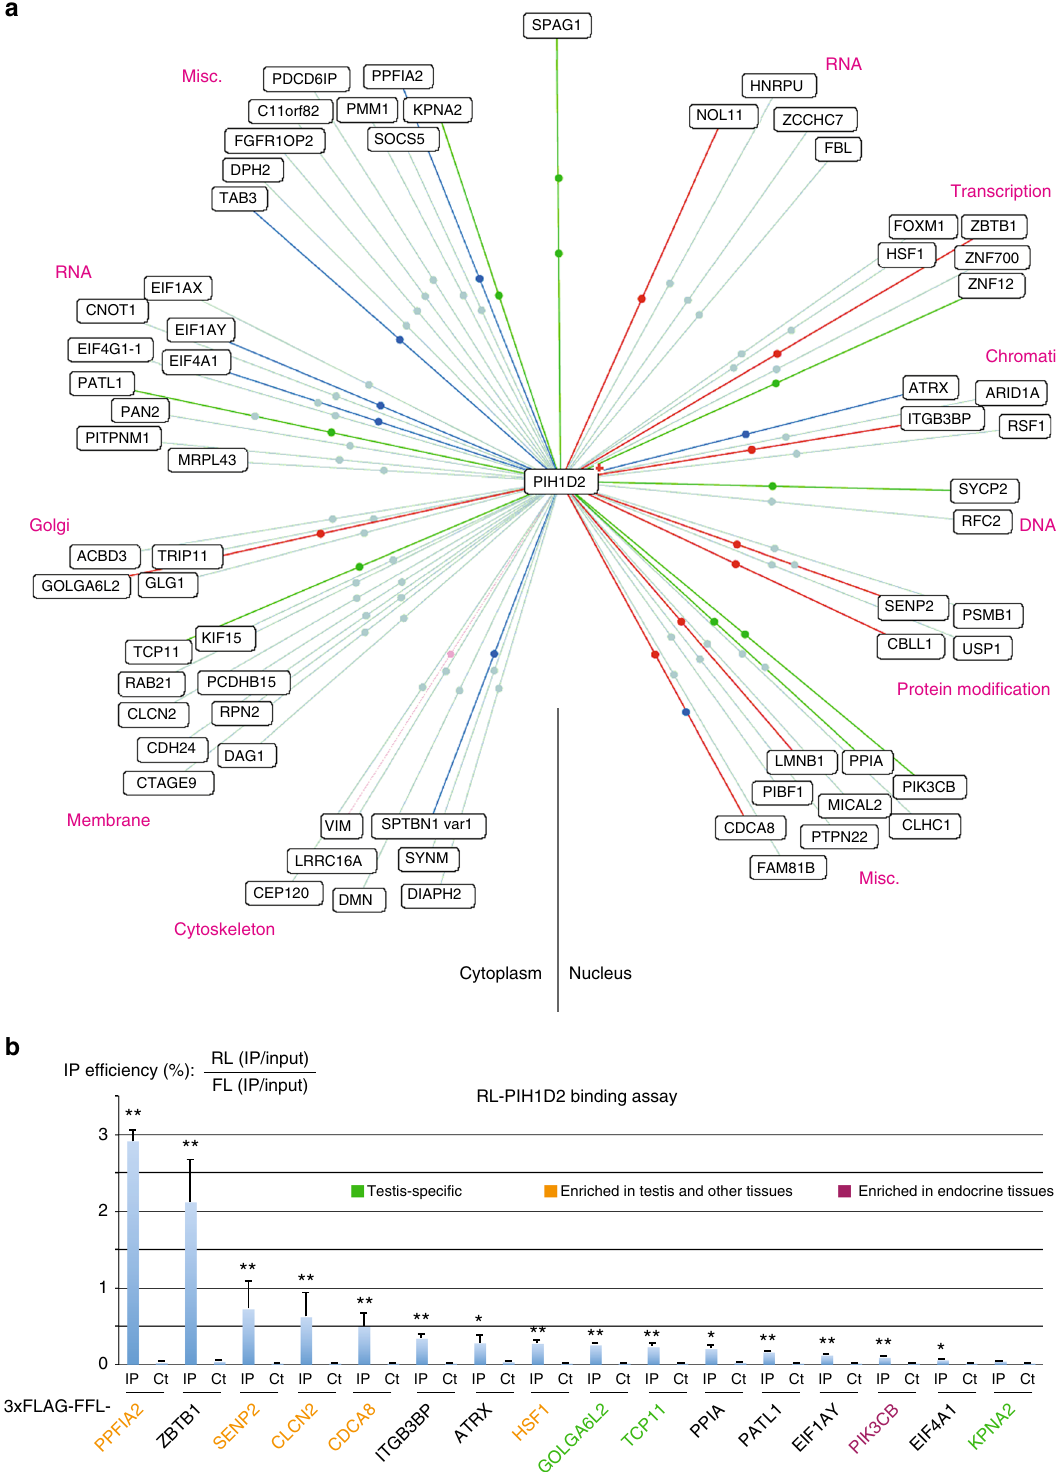
Fig. 6 Identi fi cation of PIH1D2 partners. a Results of yeast two-hybrid screens using human PIH1D2 as bait and performed with human libraries from lung carcinoma cell lines and testis. The color of the lines indicate the strength of the Y2H interaction (PBS score). a red; b dark blue; c green; d light blue. Lines with two dots indicate that the prey was found in the two libraries. b Validation of the hits found in the yeast two-hybrid screens by LUMIER co-IP assays. The graph depicts the results of LUMIER co-IP assays performed with the indicated proteins. Error bars: standard deviation. Stars: values signi fi cantly greater than six-times the mean value obtained in the control IPs without anti-FLAG antibody (Ct). * p -value < 0.05; ** p -value < 0.001